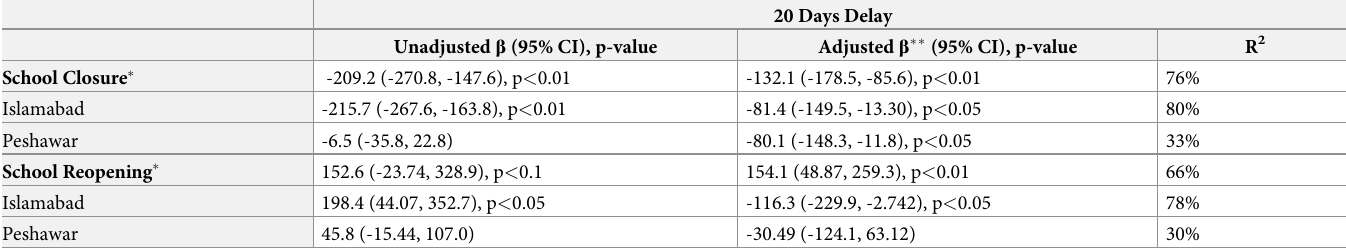
Table 3. Difference in COVID-19 incidence pre- and post- school closure and re-opening across Islamabad and Peshawar and between pre-and post- implementa- tion in Islamabad and Peshawar 20 days after NPI implementation.